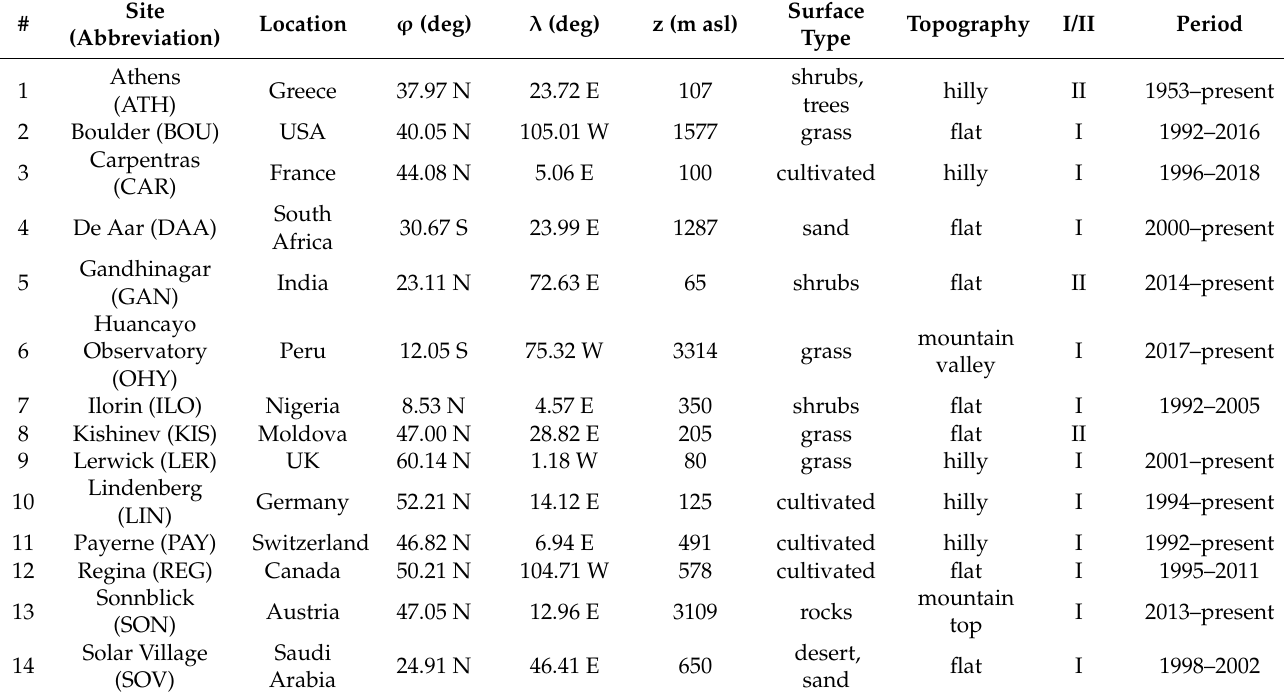
Table 1. Selected sites for the application of the mathematical determination of the k du and k dl limits. ϕ and λ are the geographical latitudes and longitudes of the sites, respectively; ϕ is given in the northern (N) or the southern (S) hemisphere, and λ east (E) or west (W) of the Greenwich meridian. The values of both ϕ and λ have been rounded to the second decimal digit. In column 9, I denotes rural and II denotes urban environment. The period of measurements is given in the last column. The selection of the sites and their solar radiation data were based on the BSRN (Baseline Surface Radiation Network), except for Athens (ATH); in this case, data from the Actinometric Station of the National Observatory of Athens not belonging to BSRN were used. The abbreviations of the sites (except for Athens) are those provided by the BSRN typology. Description of the BSRN operation is found in